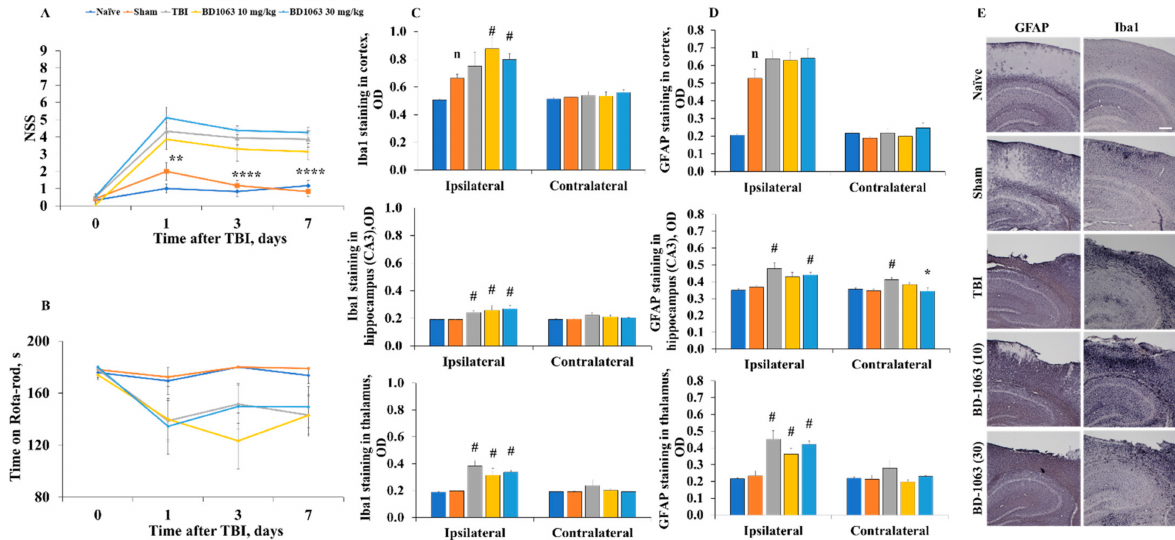
Figure 4. Posttraumatic behavioral and histological outcomes after pretreatment with the S1R antagonist BD-1063. ( A ) TBI mice had a significantly higher NSS up to 7 days postinjury. ( B ) All experimental groups spent similar time on the RR. BD-1063 treatment did not influence behavioral outcomes after TBI. Data are presented as the means ± SEM (naïve n = 6, sham n = 9, TBI n = 15, BD-1063 10 mg/kg n = 7, BD-1063 30 mg/kg n = 8). p values for differences between groups were calculated using RM two-way ANOVA followed by Fisher’s LSD test: * p < 0.05, ** p < 0.01, **** p < 0.0001 sham vs. TB. OD of the intensity of ( C ) Iba1 and ( D ) GFAP staining in the cortex, hippocampus, and thalamus. TBI induced significantly increased staining for Iba1 in the ipsilateral thalamus and for GFAP in the ipsilateral hippocampus and thalamus. ( E ) Representative images of Iba1 and GFAP staining at 7 days postinjury (total magnification = 40 × , scale bar = 100 µ m). Data are presented as the means ± SEM ( n = 5). p values for differences between groups were calculated using the Kruskal–Wallis test followed by Dunn’s test: # p < 0.05 compared with the sham group, * p < 0.05 compared with the TBI group. Differences between naïve and sham groups were calculated using the Mann–Whitney U-test: n p < 0.05 compared with the naïve